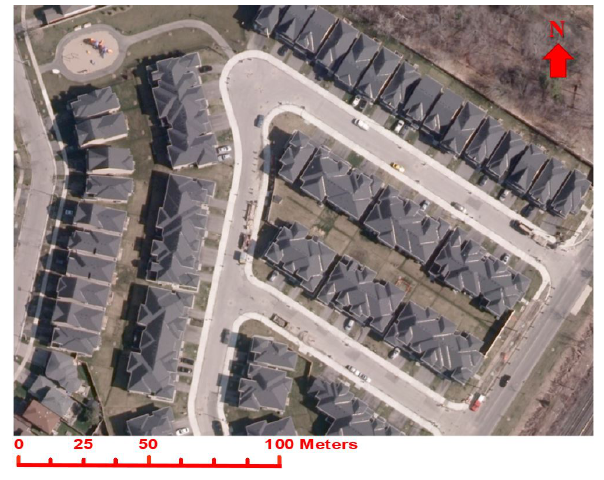
a- Aerial photo - RGB (20 cm)